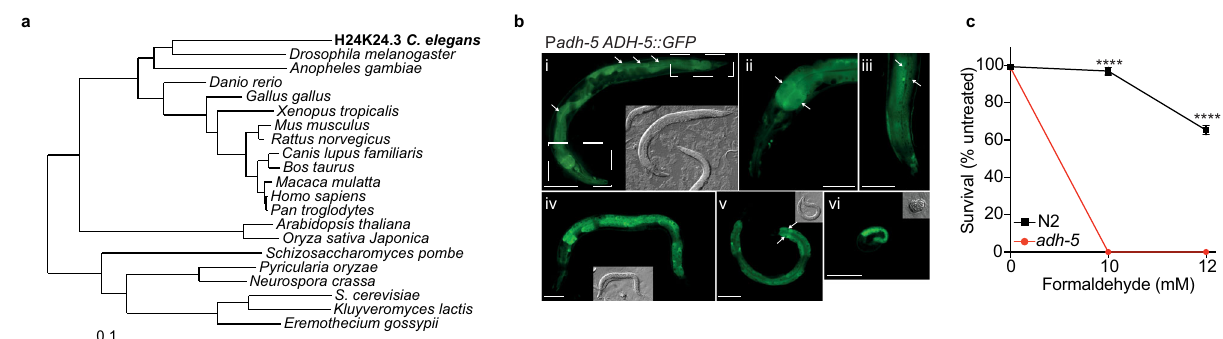
Fig. 2 H24K24.3 is the C. elegans ortholog gene of human ADH5 . a Phylogenetic analysis of ADH5 -homologue genes in eukaryote highlighting the ortholog gene (gi_71997431/H24K24.3) found in C. elegans . b Various developmental stages of a C. elegans transgenic line expressing Ex [p adh-5 ADH-5::GFP; p myo-2 tdTomato]. White arrows point to nuclei. Scale bars = 50 μ m. Grey inlays show the corresponding DIC image. i Adult stage, boxes refer to (ii and iii). ii Head area with focus on the intestine of the adult depicted in (i). iii Tail area with focus on the cuticle of the animal shown in (i). (iv) L4 stage. (v) L3 stage. (vi) Late embryo. c Survival of L1-staged WT (N2) and adh-5 mutant C. elegans upon exposure to the indicated formaldehyde (FA) concentrations measured directly after the treatment (data are presented as mean ±SEM, n = 3, one-way ANOVA, Tukey´s multiple comparison test, **** P <